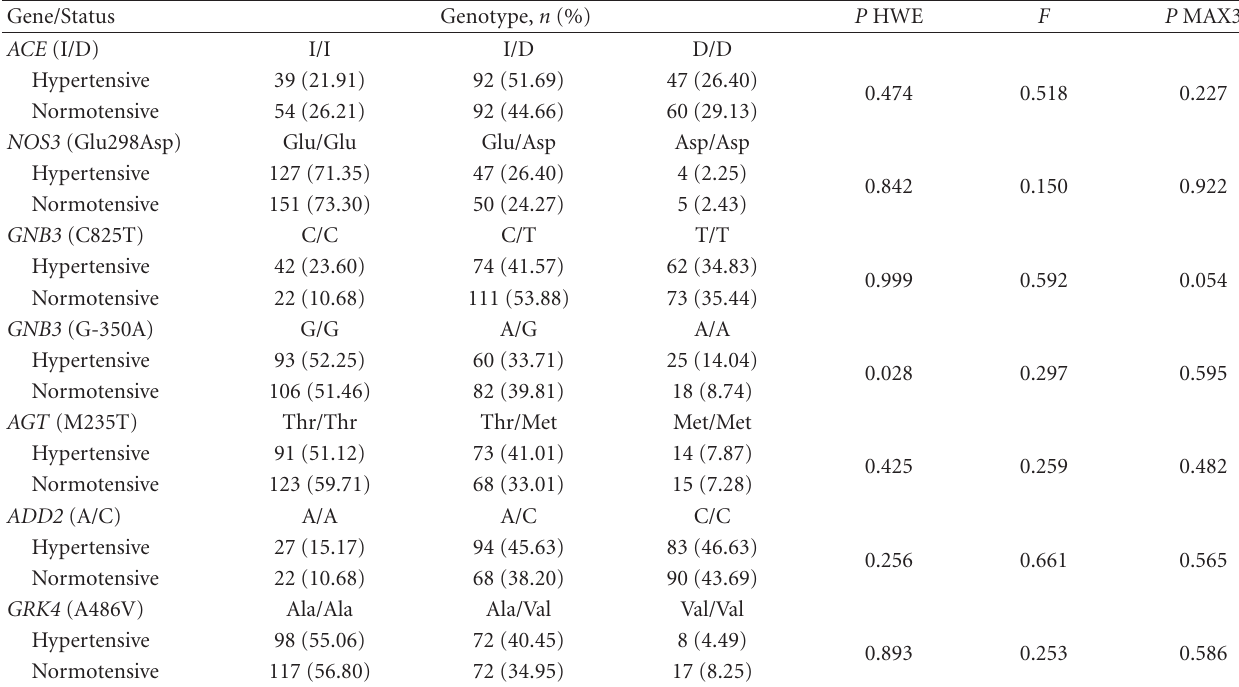
Table 5: Genotype frequencies for the seven studied polymorphisms in normotensive and hypertensive quilombo